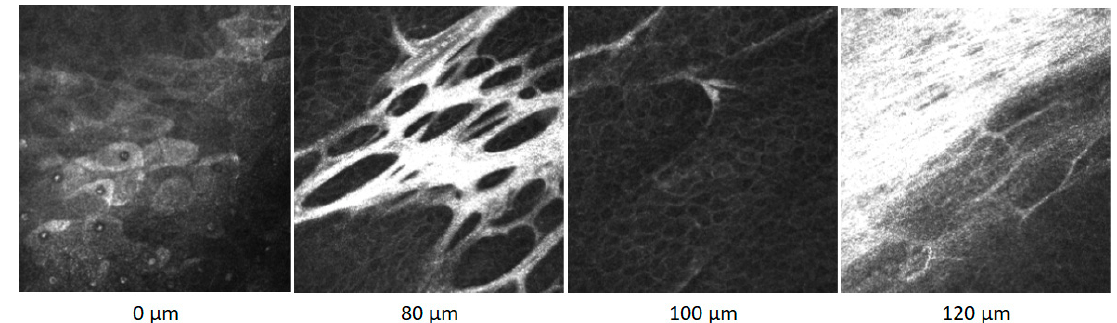
Figure 2. Confocal microscope images of a pterygium within the surface at 0 µm, through layers in deeper positions at 80 and 100 µm to the sclera at 120 µm.